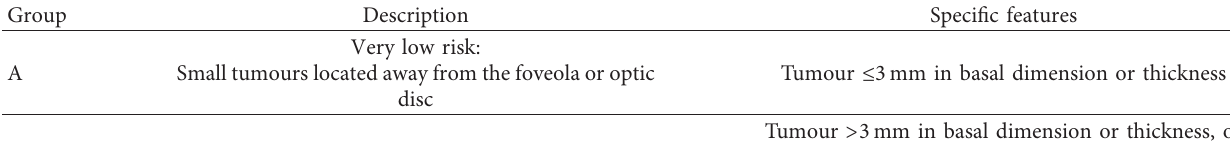
Table 1: International Classification of Intraocular Retinoblastoma